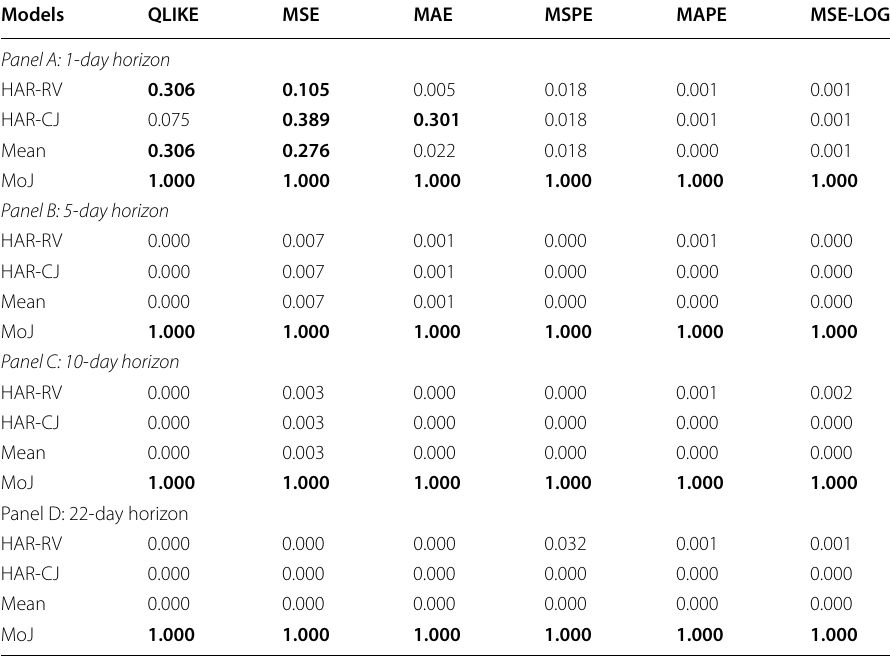
Table 2 Out-of-sample forecasting performance based on the MCS